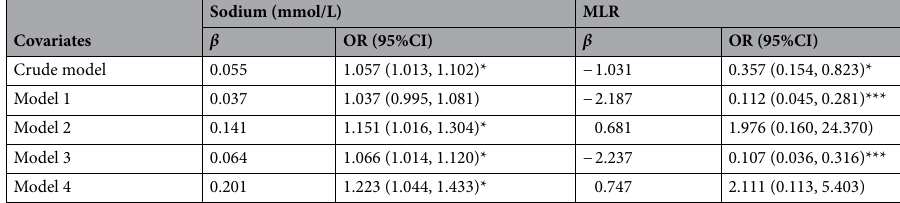
Table 4. Association of independent factors with QFT-GIT after adjusting variables. OR odds ratio; CI confidence interval; MLR monocyte-to-lymphocyte ratio. Model 1: adjusted for age, gender, race, marital status, and education level. Model 2: adjusted for age, gender, race, marital status, education level, BMI, positive TST, lived in household TB sick person, history of TB exposure, and TB medicine. Model 3: adjusted for age, gender, race, marital status, education level, arthritis classification, smoking status, alcohol use, and diabetes. Model 4: adjusted for all variables.